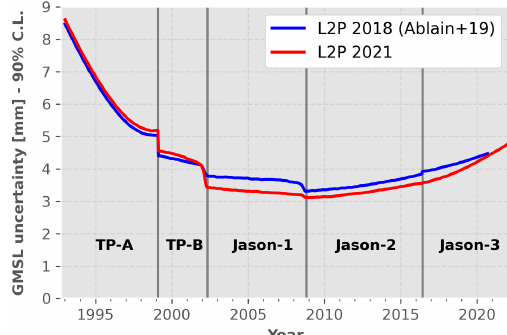
Figure 4. Comparison of the uncertainty envelopes (1.65 σ ) be- tween the L2P21 and L2P18 GMSL records. The values shown correspond to the half-width of the confidence interval. The vertical lines indicate the switches of